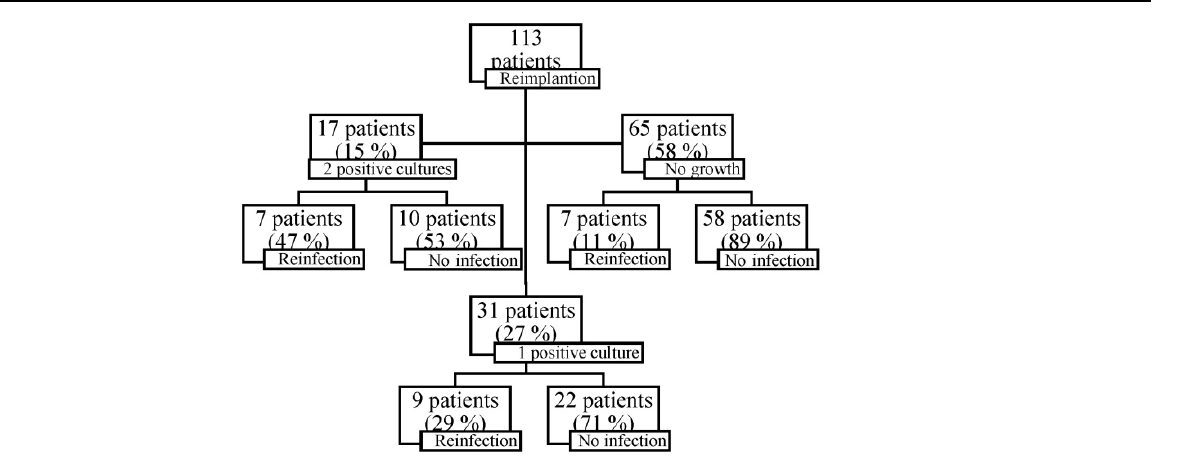
Figure 3: Survival with reinfection as an end point after two-stage revision of an infected TKA, stratified by no reinfection (blue), new infection (red) and relapse (green).